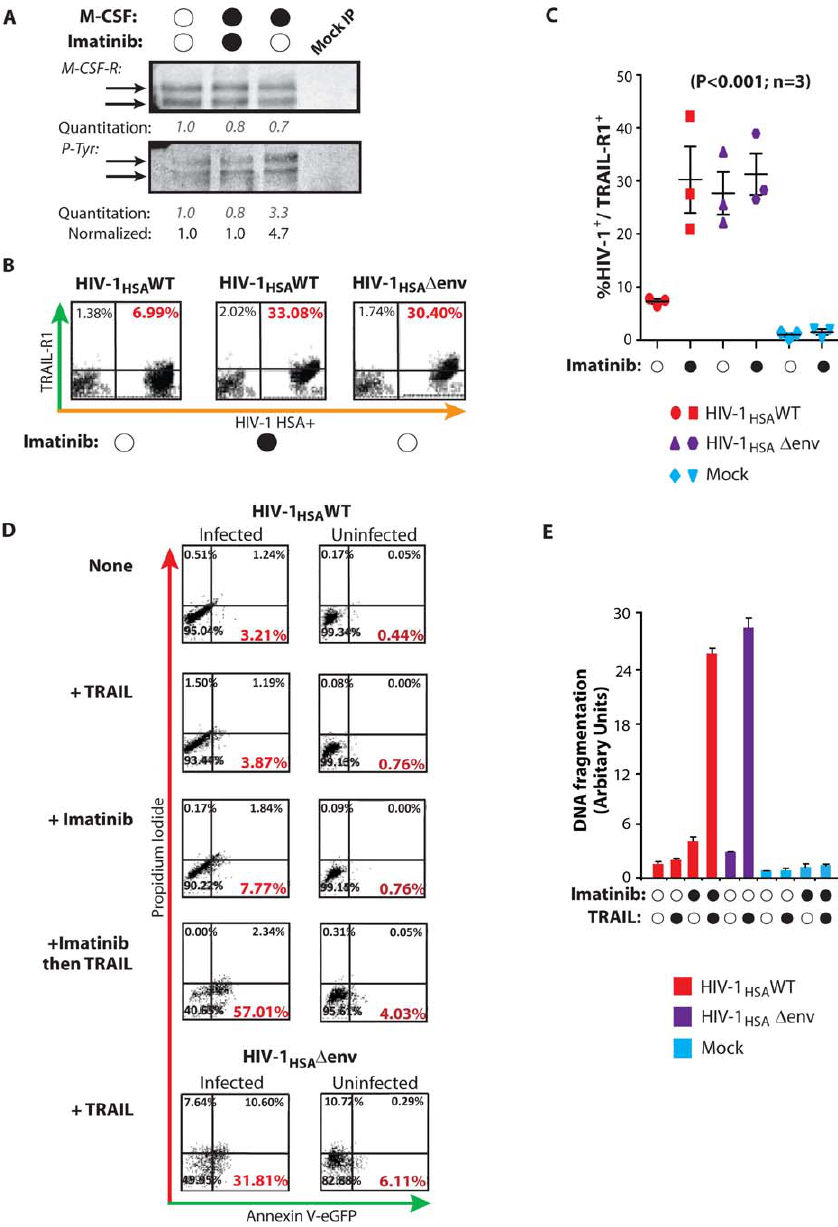
Figure 5. Imatinib Blocks M-CSF Signaling and Restores TRAIL Sensitivity of Infected Macrophages (A) Imatinib inhibits M-CSF–dependent autophosphorylation of the M-CSF receptor. Macrophages were incubated for 16 h with 2 l M Imatinib mesylate before stimulation with recombinant M-CSF for 5 min. The M-CSF receptor was immunoprecipitated from cell lysates, and M-CSF–dependent tyrosine autophosphorylation was determined by Western blotting and densitometry. (B) Imatinib upregulates TRAIL-R1 expression on wild-type–infected macrophages. HIV-1 wild-type– and D env-infected macrophages were incubated with Imatinib for 16 h and TRAIL-R1 levels were determined by flow cytometry. (C) Macrophages from three donors were treated as in (B), and statistical analysis was performed on the mean expression of TRAIL-R1 in response to Imatinib (ANOVA; error bars, SEM). (D) Imatinib restores sensitivity to TRAIL. Macrophages were incubated with Imatinib for 16 h, challenged with soluble TRAIL, or both. Apoptotic HIV-1– infected and uninfected cells in the same cultures were determined 6 h later by Annexin V and propidium iodide staining and flow cytometry. Apoptotic cells were Annexin V þ , propidium iodide (cid:2) (lower right quadrant). Imatinib renders HIV-1 wild-type–infected macrophages susceptible to TRAIL-mediated apoptosis. (E) Macrophages were treated as in (D), except apoptosis was determined 16 h after TRAIL exposure by ELISA for apoptotic histone-associated cellular DNA fragmentation in macrophage lysates (cell death ELISA; error bar, SD).